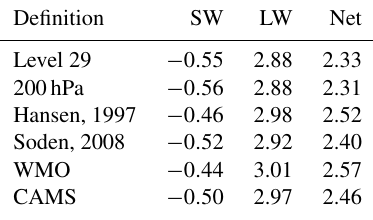
Table 5. Shortwave, longwave, and net instantaneous radiative forc- ings (in Wm − 2 ) calculated with different tropopause